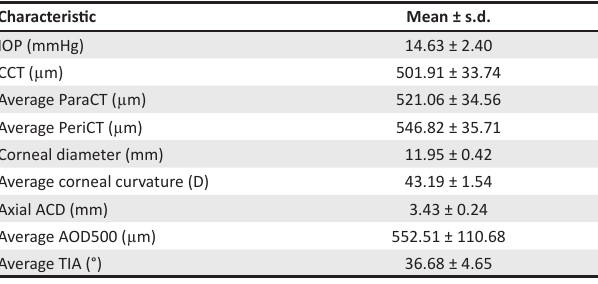
TABLE 1: Means and standard deviations for ocular characteristics.